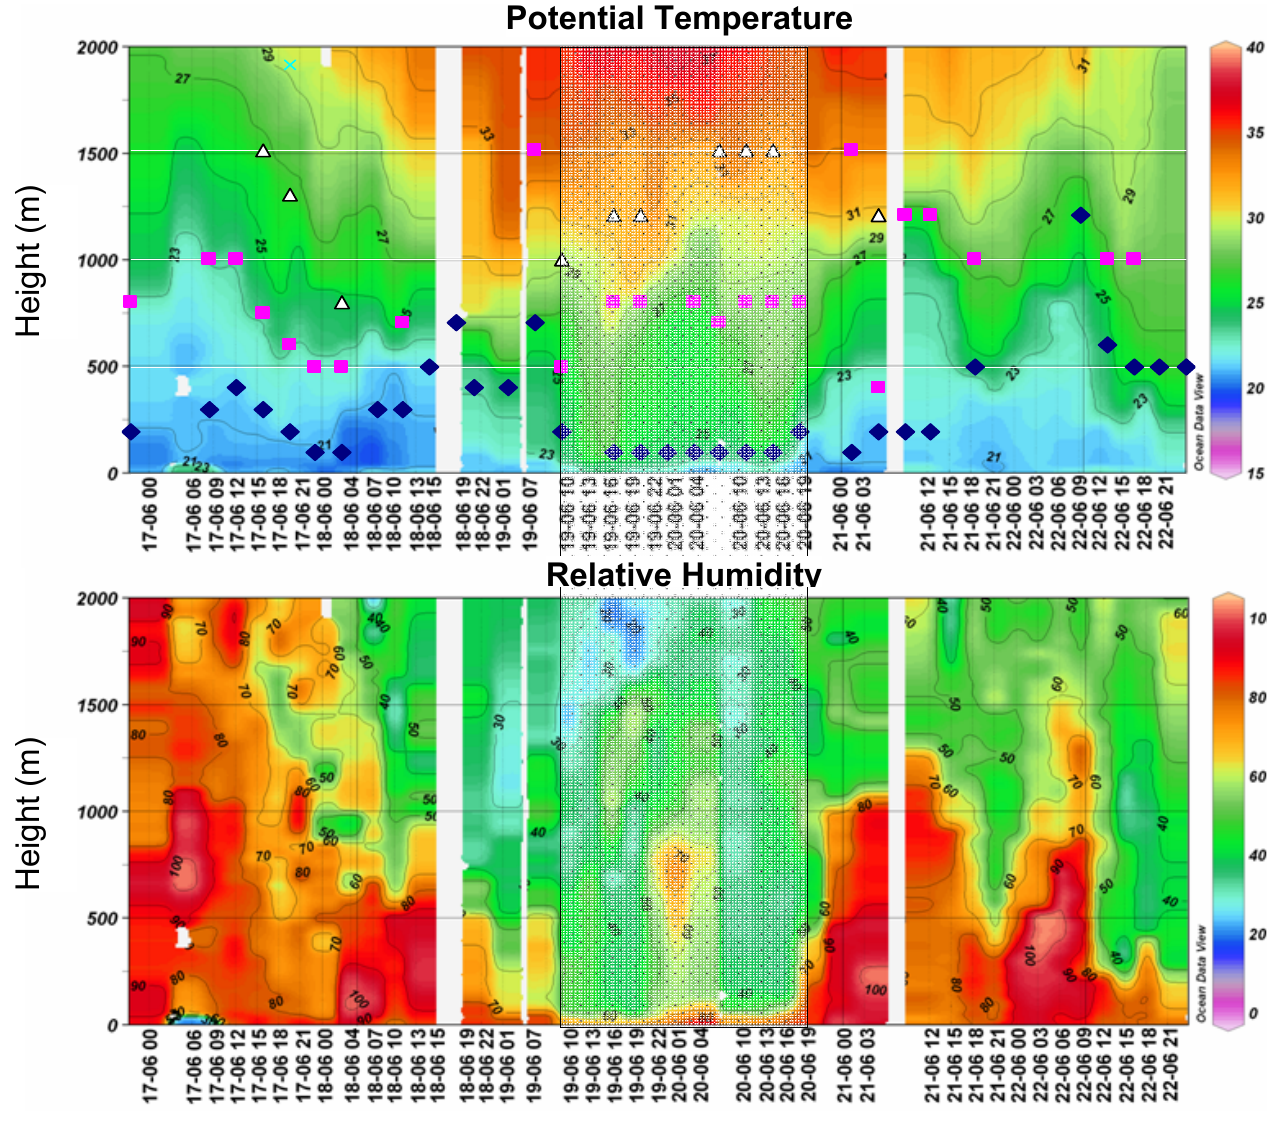
Fig. 4. In the top figure, we show the time-height cross section of the vertical structure of T p ( ◦ C) and the heights of the inversions found by visual inspection. The bottom figure shows the vertical structure of RH(%). These figures clearly show the impact of the changes in synoptic conditions on the vertical structure of the MABL during the period corresponding to the shaded area in Fig. 3. Multiple inversions can also be